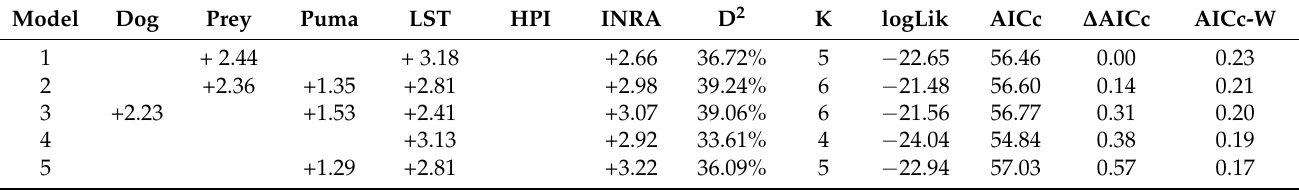
Table 7. Exploratory analysis of potential explanatory variables for observed variability in the appar- ent occurrence of South American grey fox ( Lycalopex griseus ). Only the best five models, as ranked by AICc values, are shown. Positive/negative signs indicate variables and effects considered by each model. Codes are the same as in Table